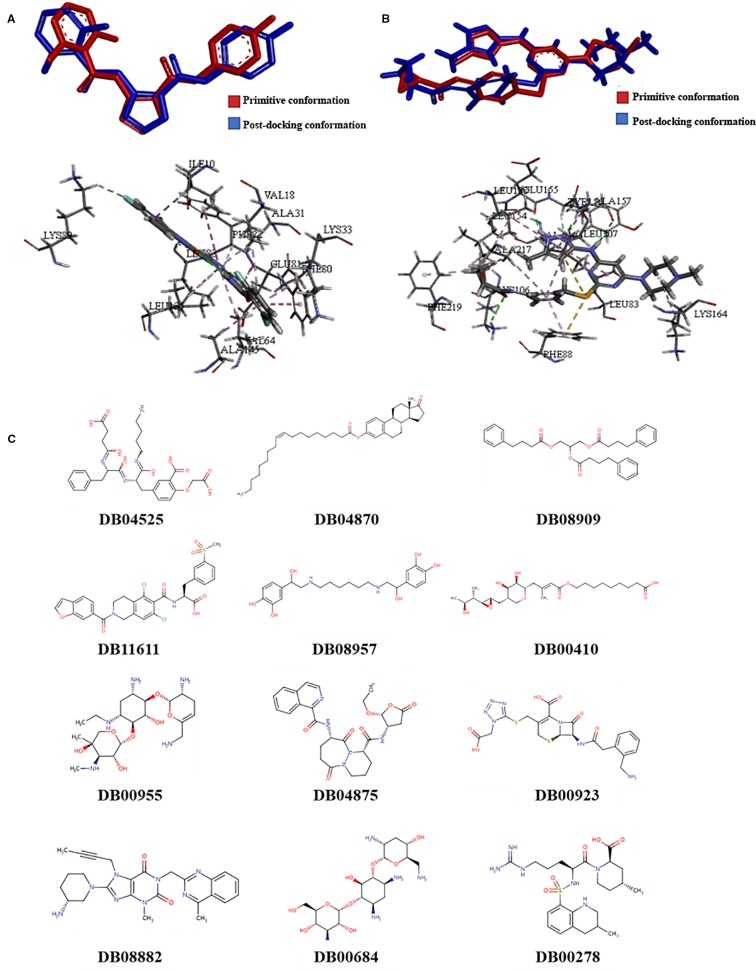
The results of screening of novel drug compounds for CDK1 and AURKB (A): up: The comparison of conformations of the initial ligand before and after docking with CDK1; below: The interactions between initial ligand and CDK1; (B): up: The comparison of conformations of the initial ligand before and after docking with AURKB; below: the interactions between initial ligand and AURKB; (C) The structures of candidate compounds.